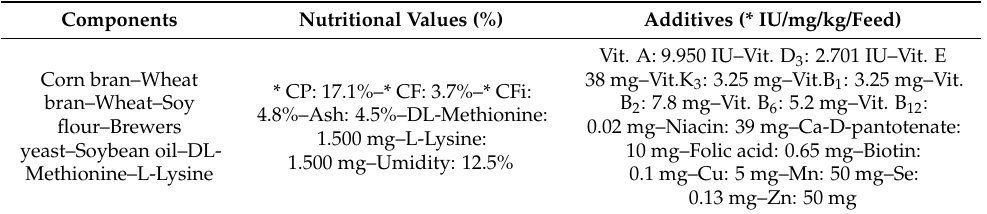
Table 1. The composition of the pellet feed specifically for exotic